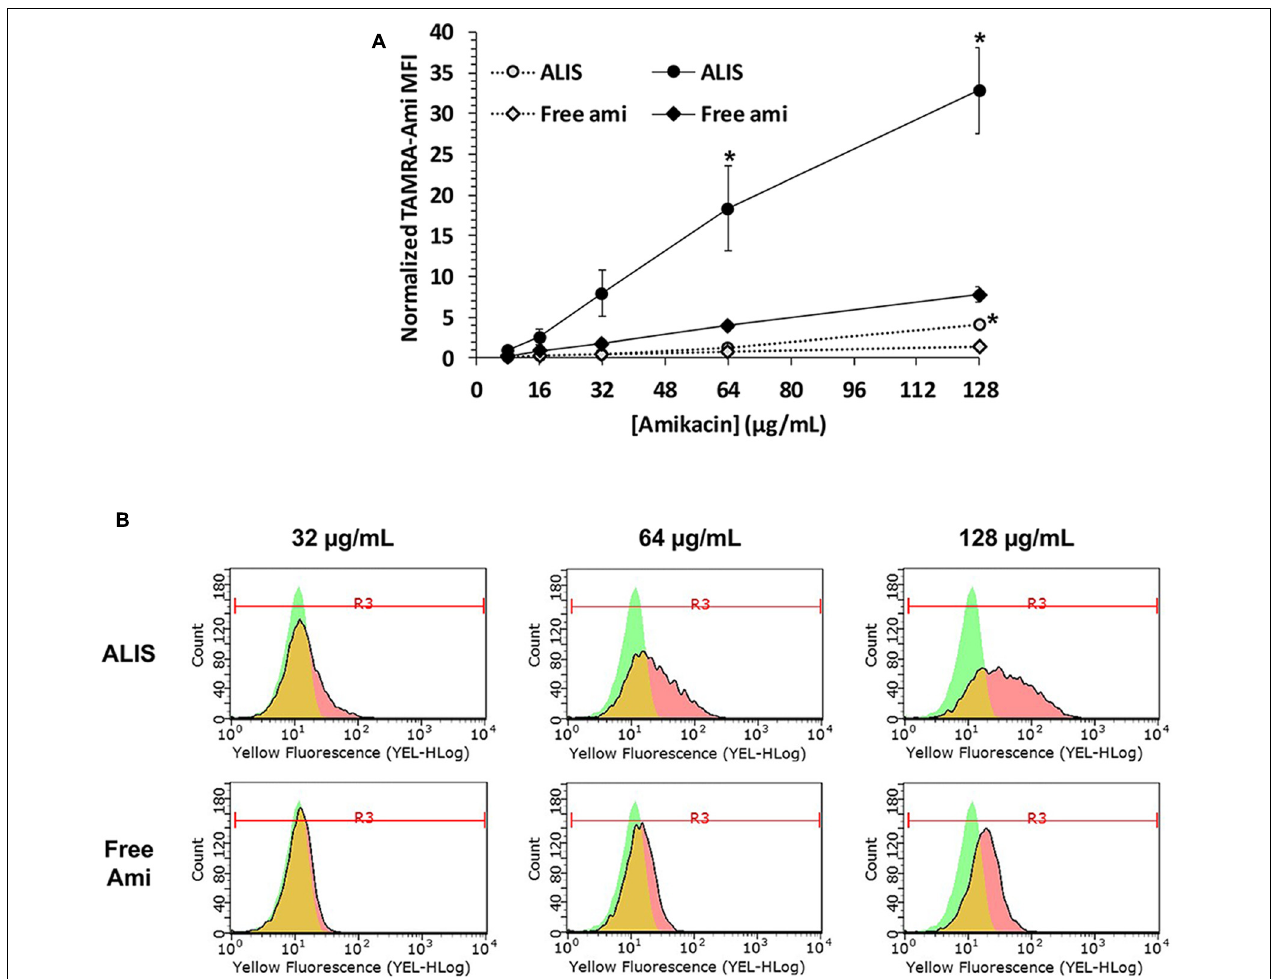
FIGURE 3 | Quantification of liposomal and free amikacin uptake into human macrophages by flow cytometry. ALIS demonstrated higher uptake into differentiated THP-1 macrophages than free amikacin at each concentration. Macrophages were exposed to increasing concentrations of either ALIS or free amikacin (0.44% labeled with TAMRA) for 4 h (gray symbols) or 24 h (black symbols) and, cell monolayers were resuspended, then cellular TAMRA fluorescence was quantified by flow cytometry. Panel (A) shows normalized mean fluorescence intensity (MFI) at each concentration averaged from three independent experiments. Panel (B) shows representative flow cytometry histograms with gating for the MFI after 24 h treatment from one experiment. Green represents control cells, red represents cells treated with ALIS or free amikacin, and yellow indicates overlap between the two histograms. ∗ P < 0.05 vs. free amikacin at the same concentration and timepoint.